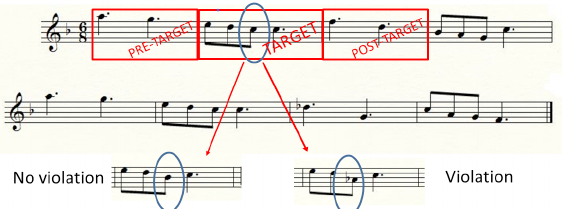
Figure 4. Example of AOIs designed for local analyses for a musical excerpt: PRE-TARGET, TARGET (with violation tone mode or no violation tone mode) and POST-TARGET measures.